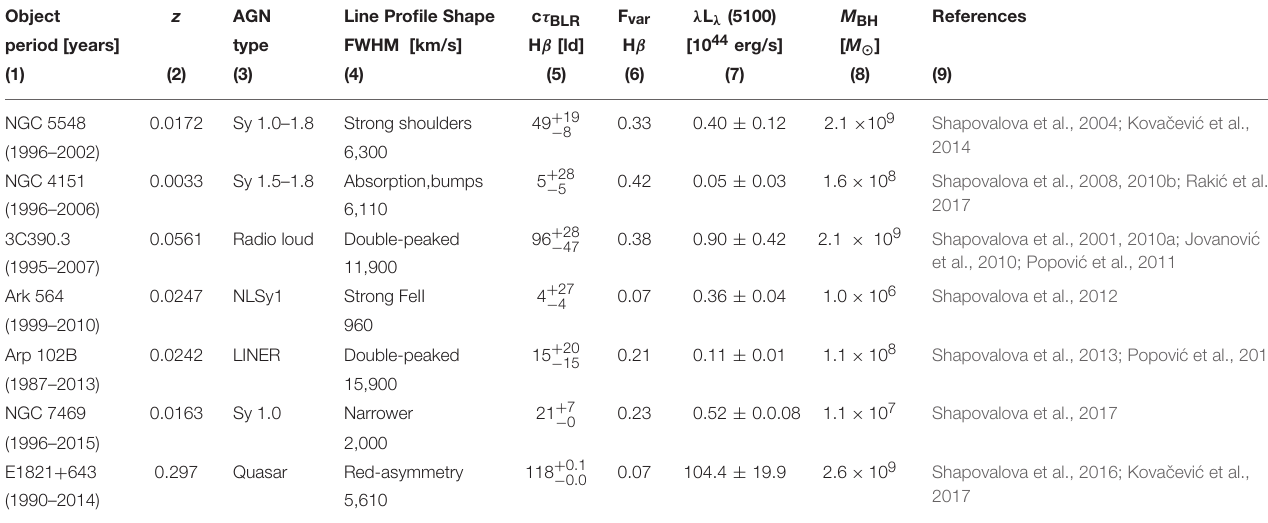
TABLE 1 | Spectral characteristics of the